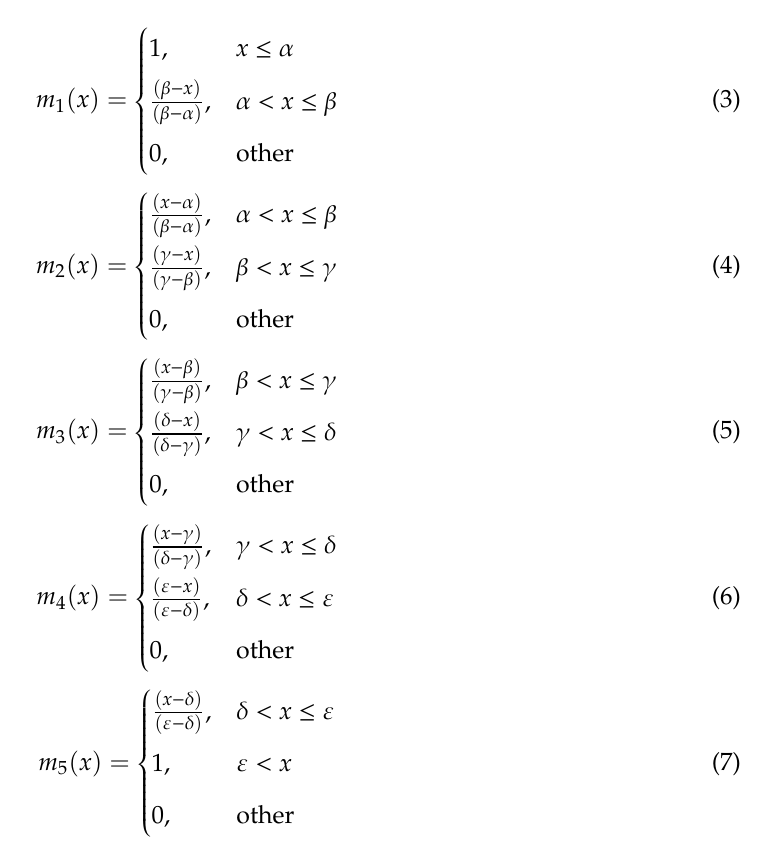
Figure 3. Figure 3. The membership functions of the linguistic Figure 3. The membership functions of the linguistic variables.